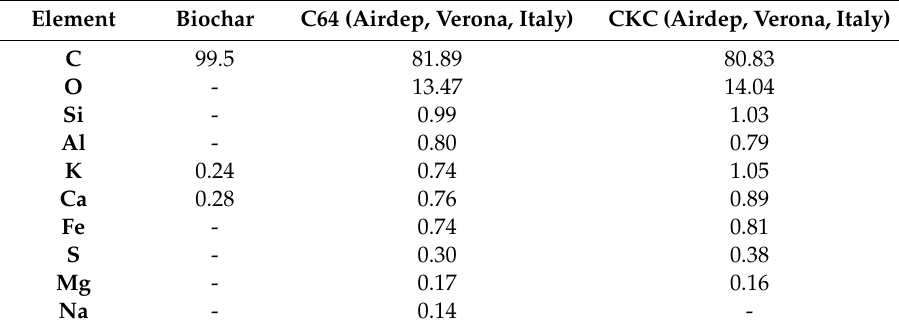
Table 2. Composition in terms of weight fraction for the materials tested.